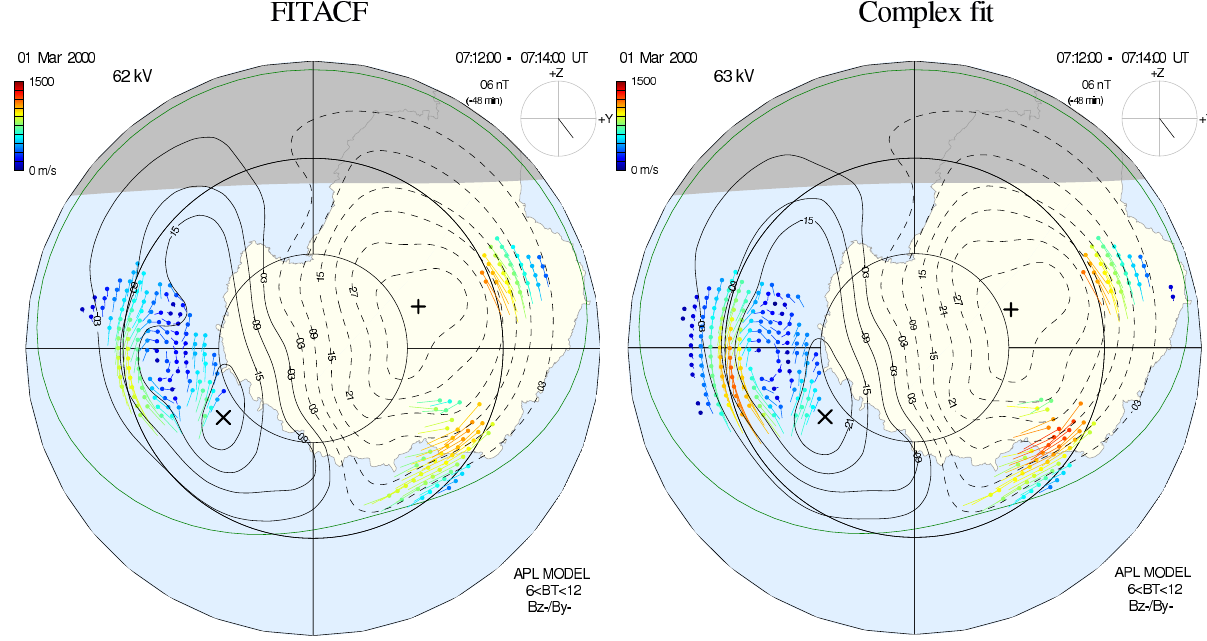
Fig. 7. Fitted model plasma convection velocities (coloured vectors) and electric field potential contours over the Southern Hemisphere at 07:12–07:14UT 1 March 2000. As in Fig. 6, the left panel shows results obtained using the conventional FITACF procedure, while the right panel represent the results based on the new